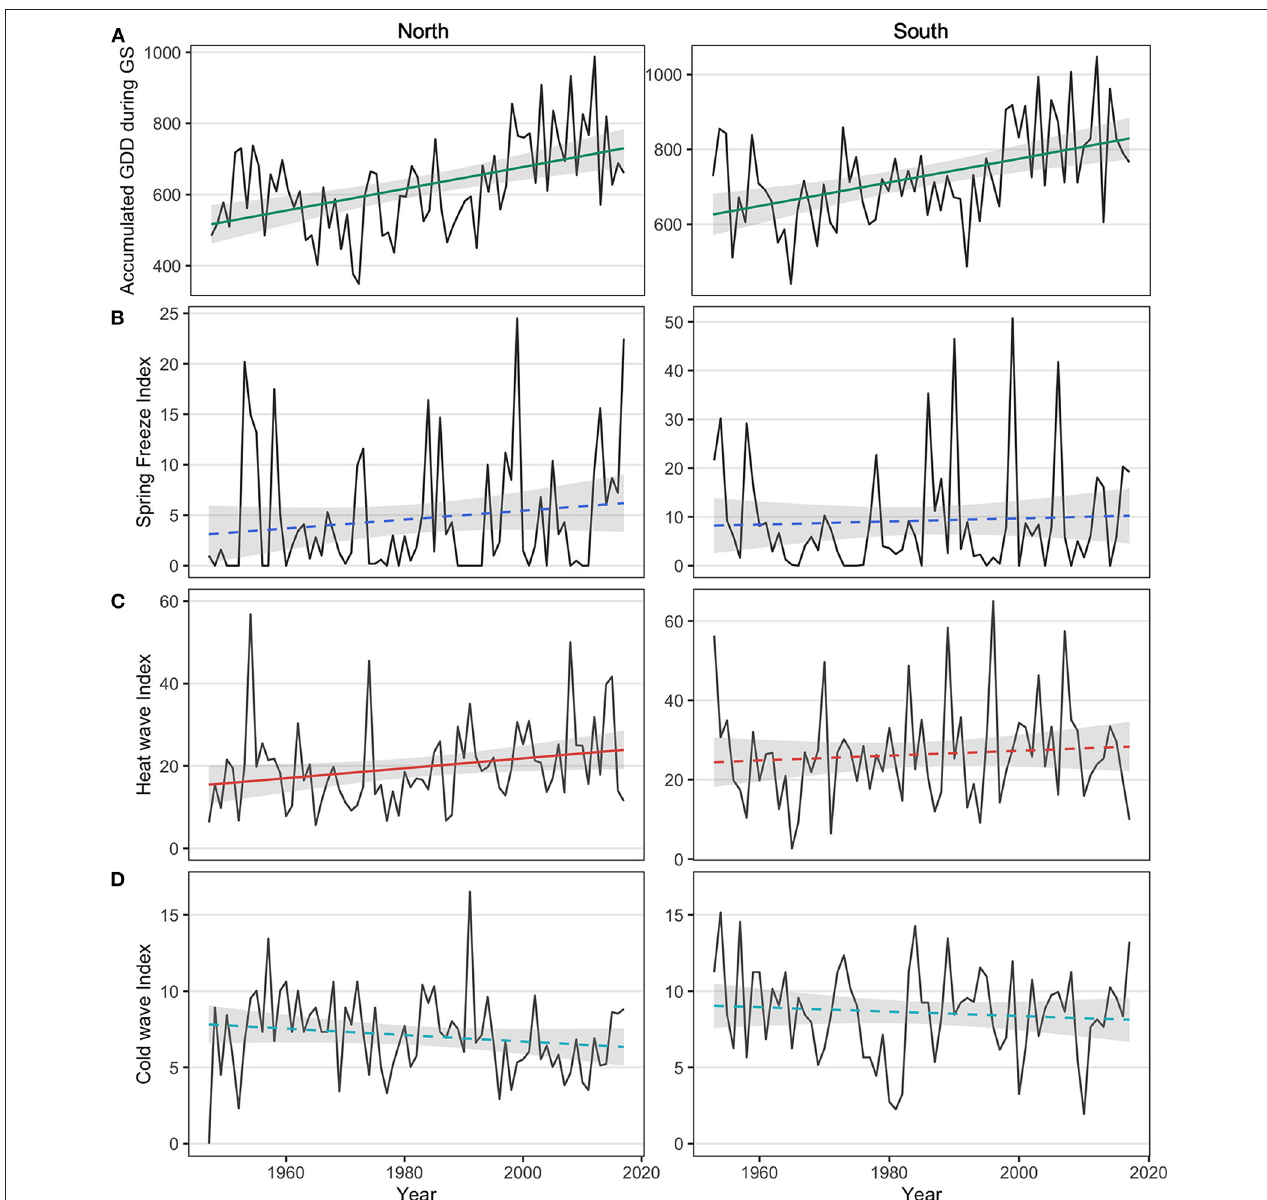
FIGURE 2 | (A) Accumulated growing degree-days (GDD) during the growing season (GS) for the northern region (left panel; linear regression: y = 516.69 + 3.05; p < 0.0001) and the southern region (right panel; y = 626.40 + 3.16x; p < 0.0001); (B) accumulated degree-days during the most severe spring frost of each year for the northern region y = 3.11 + 0.04x; p = 0.21) and the southern region ( y = 8.19 + 0.03x; p = 0.68); (C) accumulated degree-days during the most severe heat wave of each year for the northern region (y = 15.43 + 0.12x; p = 0.04) and the southern region ( y = 24.42 + 0.06x; p = 0.47): and (D) absolute accumulated degree-days during the most severe cold wave of each year for the northern region (y = 7.79 - 0.02x; p = 0.17) and the southern region ( y = 9.11–0.017x; p = 0.36). Confidence interval predictions (shaded area) were calculated with α = 0.05. Solid lines indicate a significant relationship while dashed lines indicate a non-significant relationship.